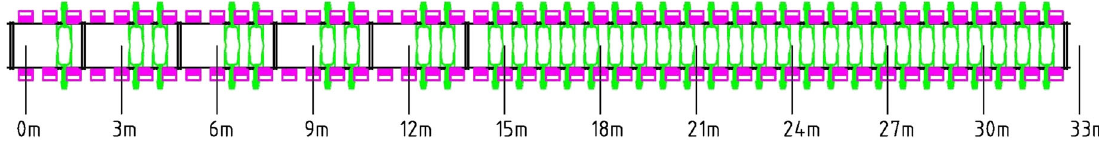
FIG. 7. Schematic of the bunching section. The lattice layout was adjusted to take into account several engineering constraints (RF feed-through, etc.) and to allow for a modular setup.